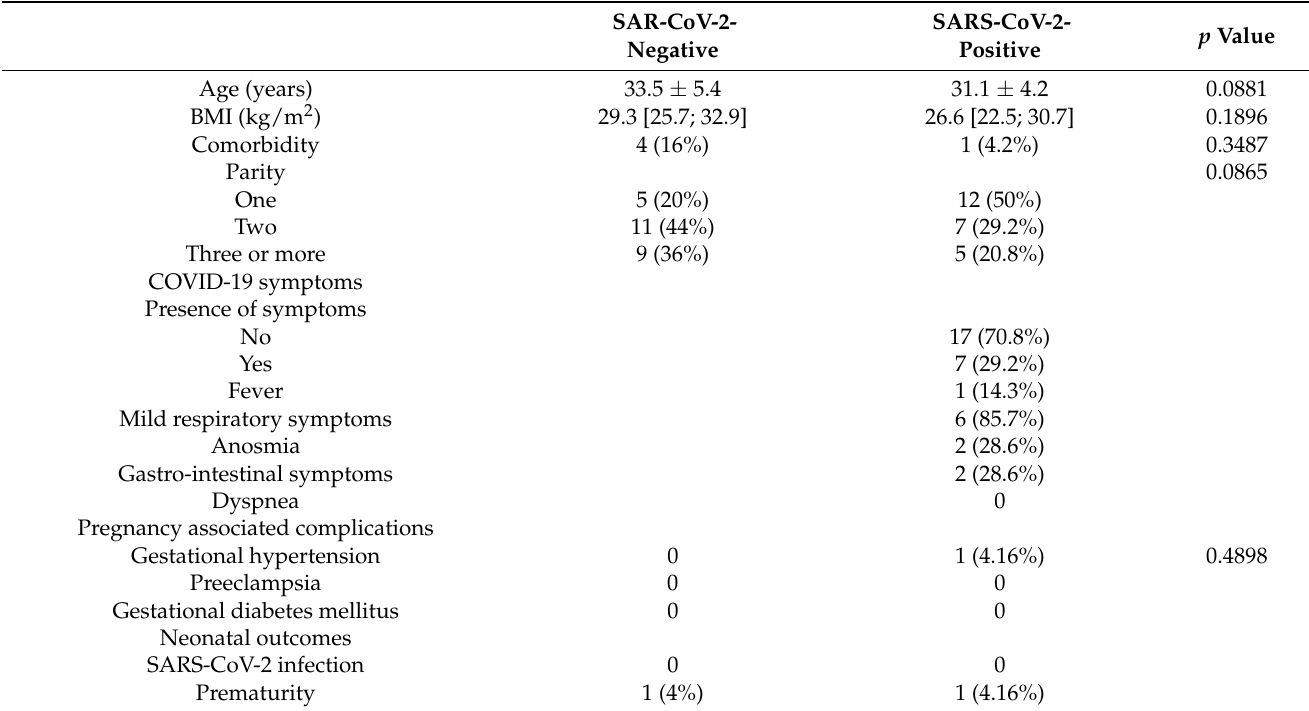
Table 1. Characteristics of Study